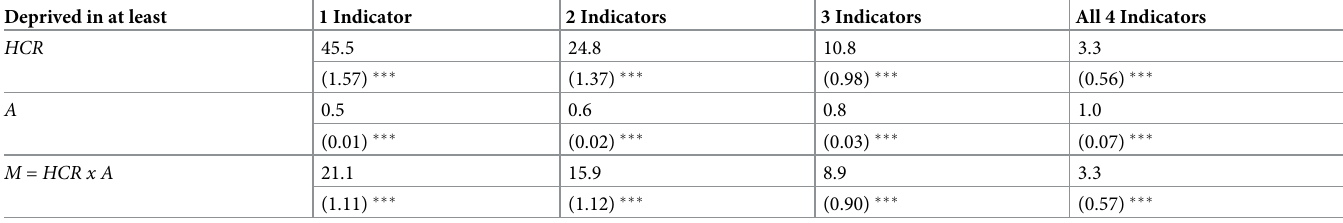
Table 3. Multidimensional deprivation measures for the entire sample. Deprived in at least 1